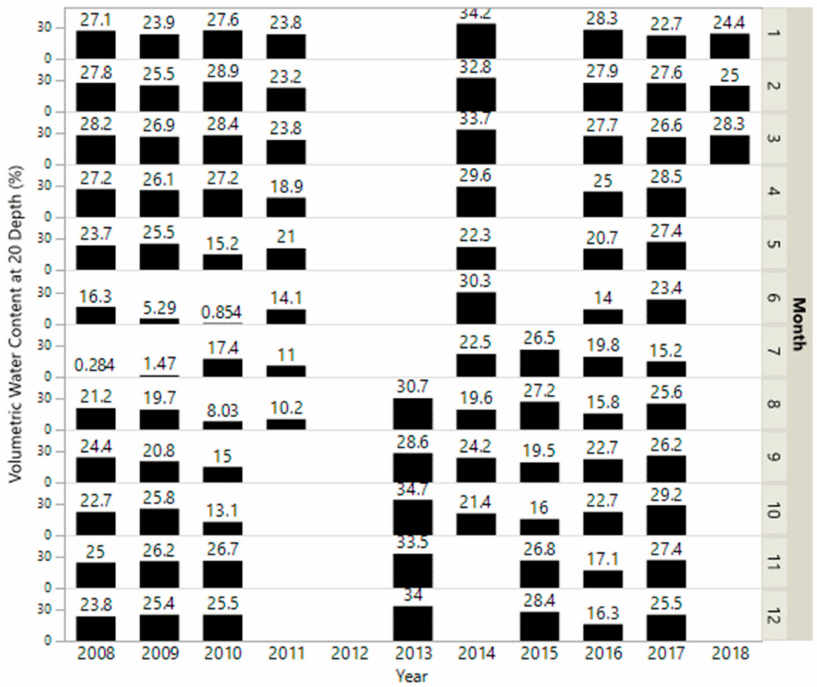
Figure A4. Monthly average volumetric water content (%) at 20 cm depth by